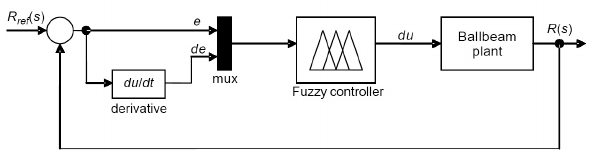
Figure 7: Fuzzy logic controller.